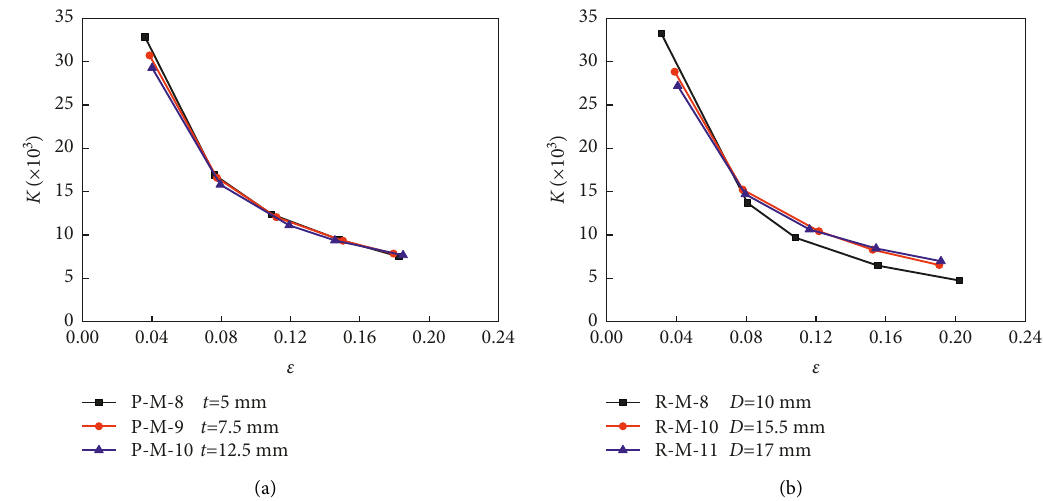
Figure 24: Secant stiffness of material specimens with different cross sections. (a) Specimens in group P. (b) Specimens in group R.